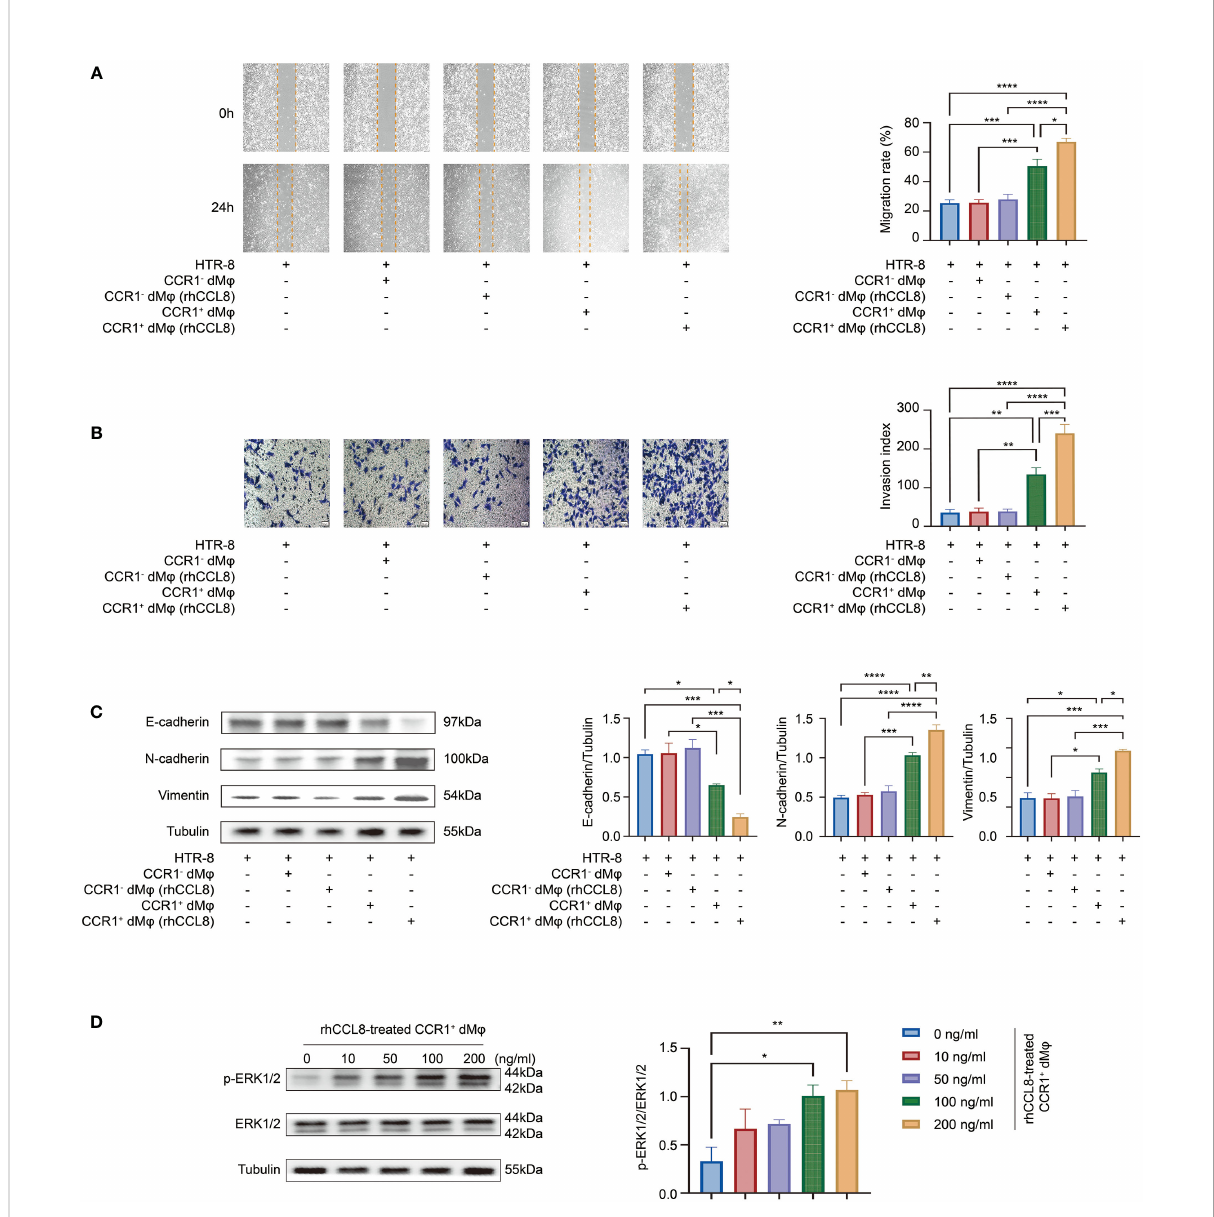
FIGURE 5 CCL8 enhances the effect of CCR1 + dM j on trophoblast functions. (A – C) HTR-8 cells were co-cultured with CCR1 - dM j or CCR1 + dM j pretreated with or without rhCCL8. (A) Scratch wound healing assay and quantitation were used to represent trophoblast migration (n=5 per group, 2 independent experiments). (B) Invasion assay and quantitation were applied to show the invasive activity of trophoblast cells (n=5 per group, 2 independent experiments). (C) WB was performed to examine the expression of E-cadherin, N-cadherin, and vimentin in HTR-8 cells treated as indicated. Images are representative of 3 samples from 3 independent experiments. (D) Effects of CCR1 + dM j pretreated with different dosages of rhCCL8 on the activation of the ERK1/2 pathway in HTR-8 cells. Images are representative of 3 samples from